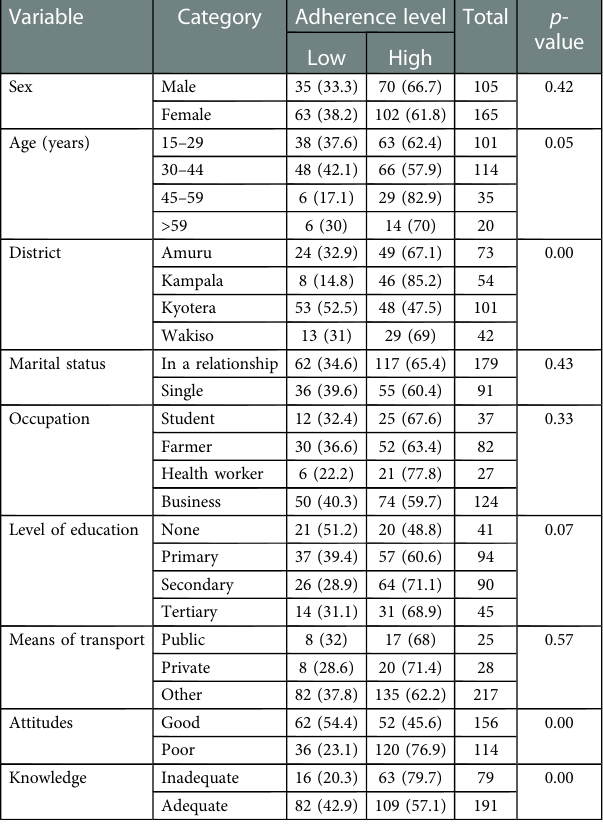
TABLE 9 The association between demographic characteristics and adherence to COVID-19 prevention measures. Variable